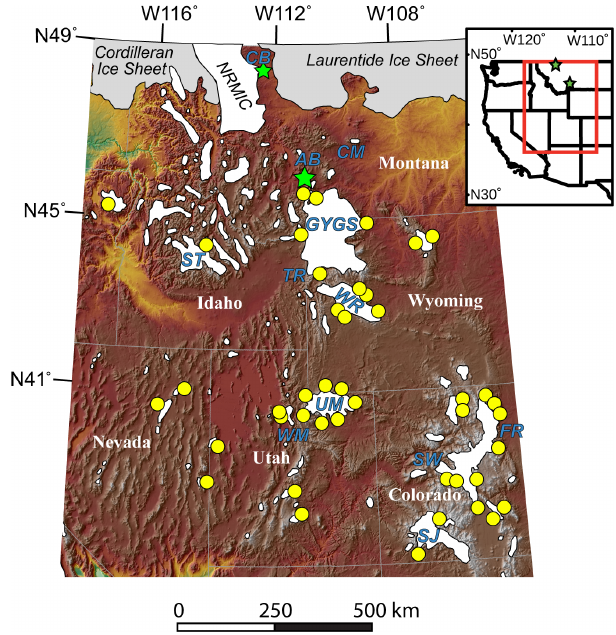
Figure 1. Pleistocene ice extents in the northern US Rocky Moun- tains (after Porter et al., 1983; Pierce, 2003) with the locations of our two field sites, Cut Bank Creek (CB) in the Lewis Range and Pine Creek, South Fork Deep Creek, and Cascade Creek in the northern Absaroka Range (AB) indicated by green stars. Loca- tions of previously established age control are indicated by yellow circles including the Greater Yellowstone glacial system (GYGS), Crazy Mountains (CM), Wind River (WR), Sawtooth (ST), Wasatch (WM), Uinta (UM), Front Range (FR), Sawatch (SW), and San Juan (SJ) ranges. General outlines of the Cordilleran and Laurentide ice sheets as well the northern Rocky Mountain ice cap (NRMIC) are also shown. Map of western North America (inset) with state out- lines. Green stars indicate our study areas, and the red box shows the approximate coverage of the main